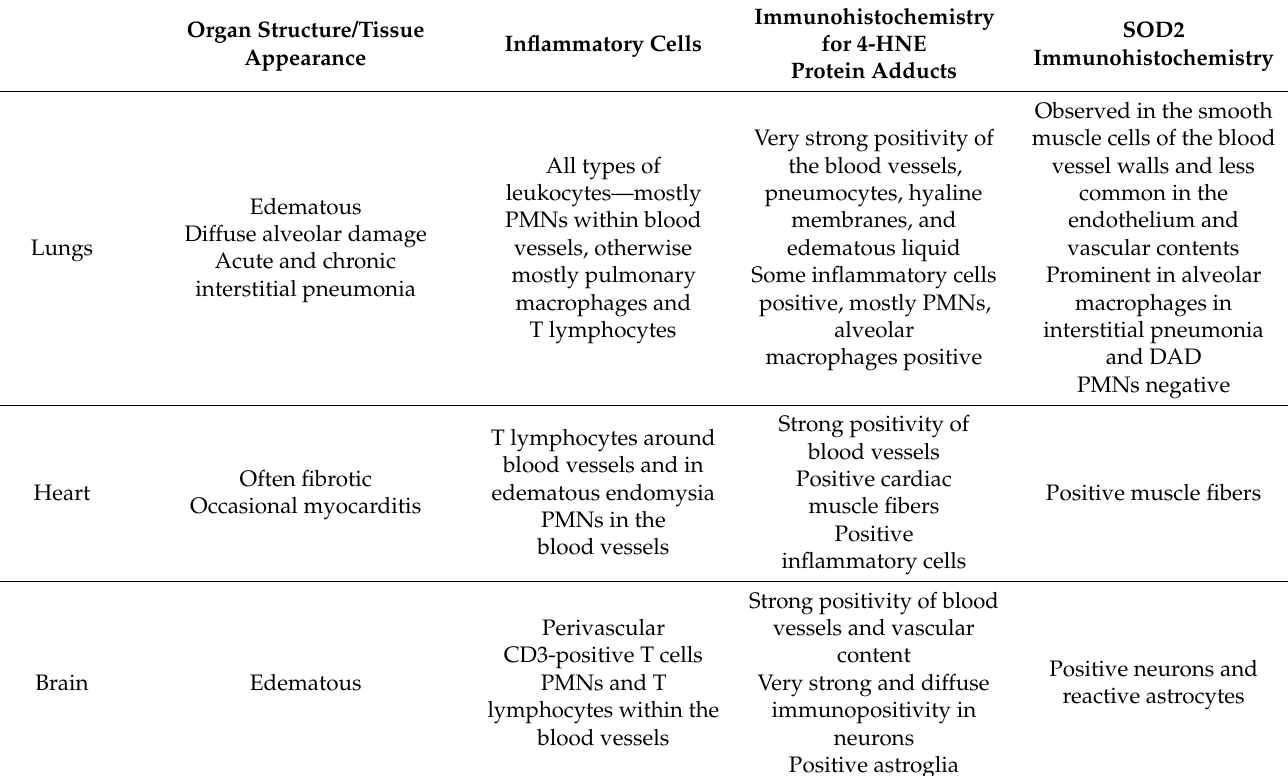
Figure 5. Histology of the liver of a COVID-19 patient with signs of steatosis (HE, 100×). Hepatocytes show lipid droplets of different sizes (arrows), while in the portal space, a moderate lymphocyte infiltrate (asterisk) is present. Table 2. Summary of the histological analysis and immunohistochemistry for 4-HNE protein adducts in the vital organs of patients deceased after aggressive COVID-19. The most common findings observed for all patients or for patients whose respective vital organs were most severely affected by SARS-CoV-2 infection are summarized.